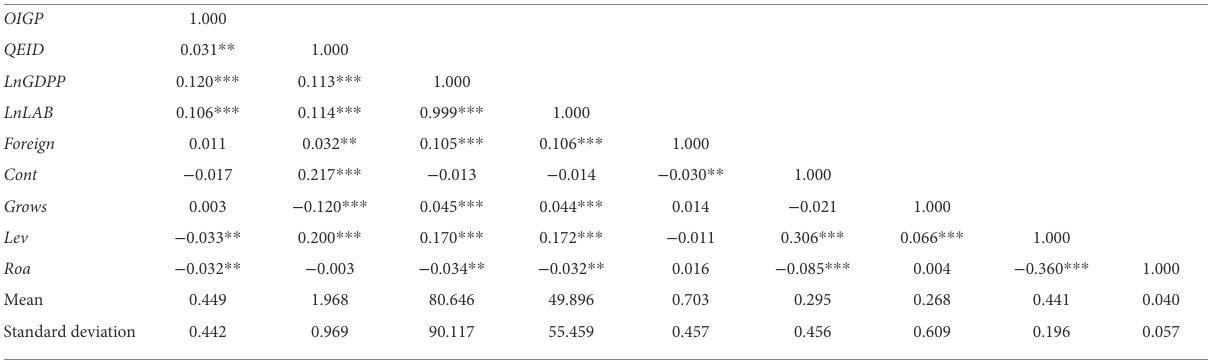
TABLE 3 The results of descriptive statistics and correlation